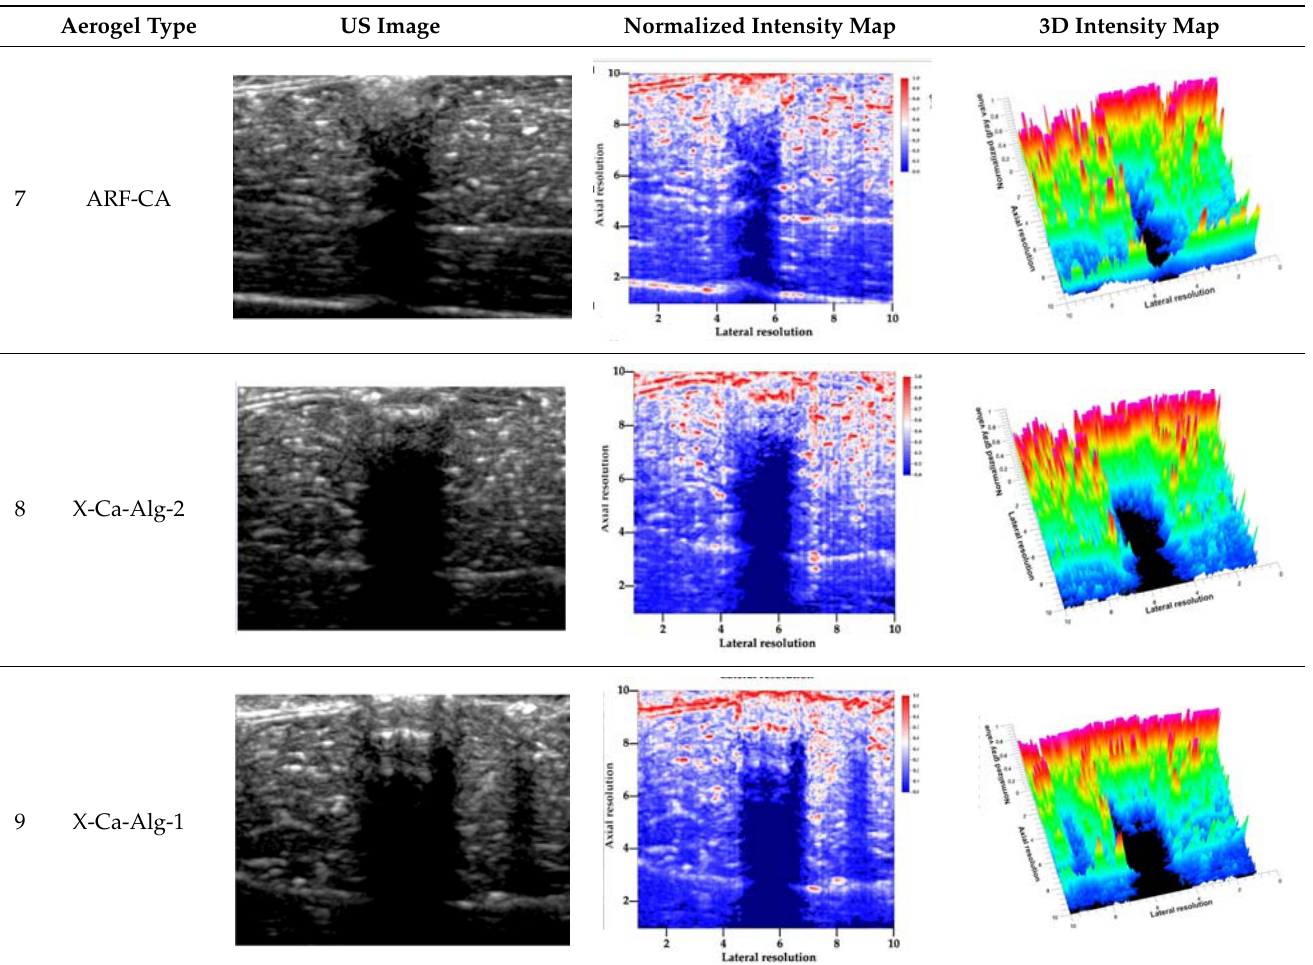
Table 6. Measurement of α for three different environments; Aq, SC and SM at a scan frequency of 8.5 MHz.